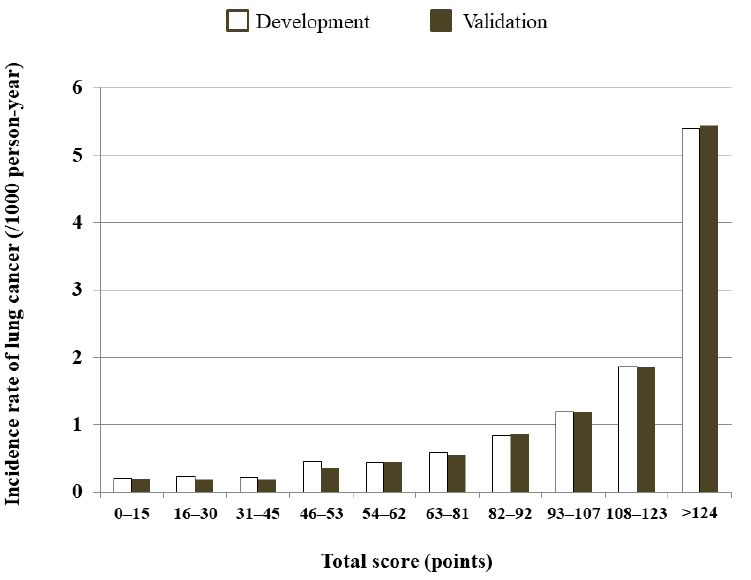
Figure 4. Predicted 5-year lung cancer incidence rate (per 1000 person-years (PYs)) based on decile score using the development and validation cohorts.